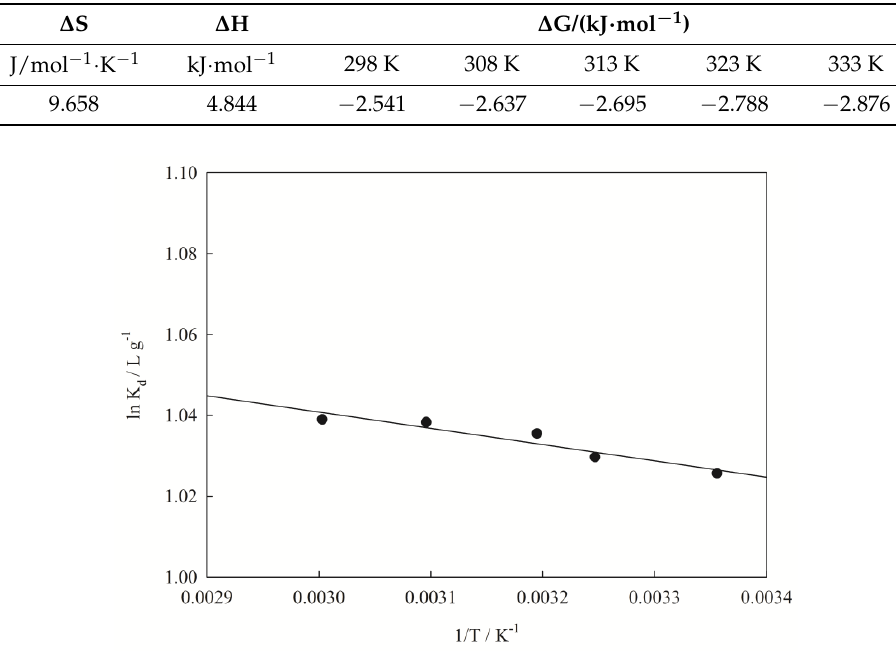
Figure 6. Relationship between 1/T and ln K d for nano I-S m .